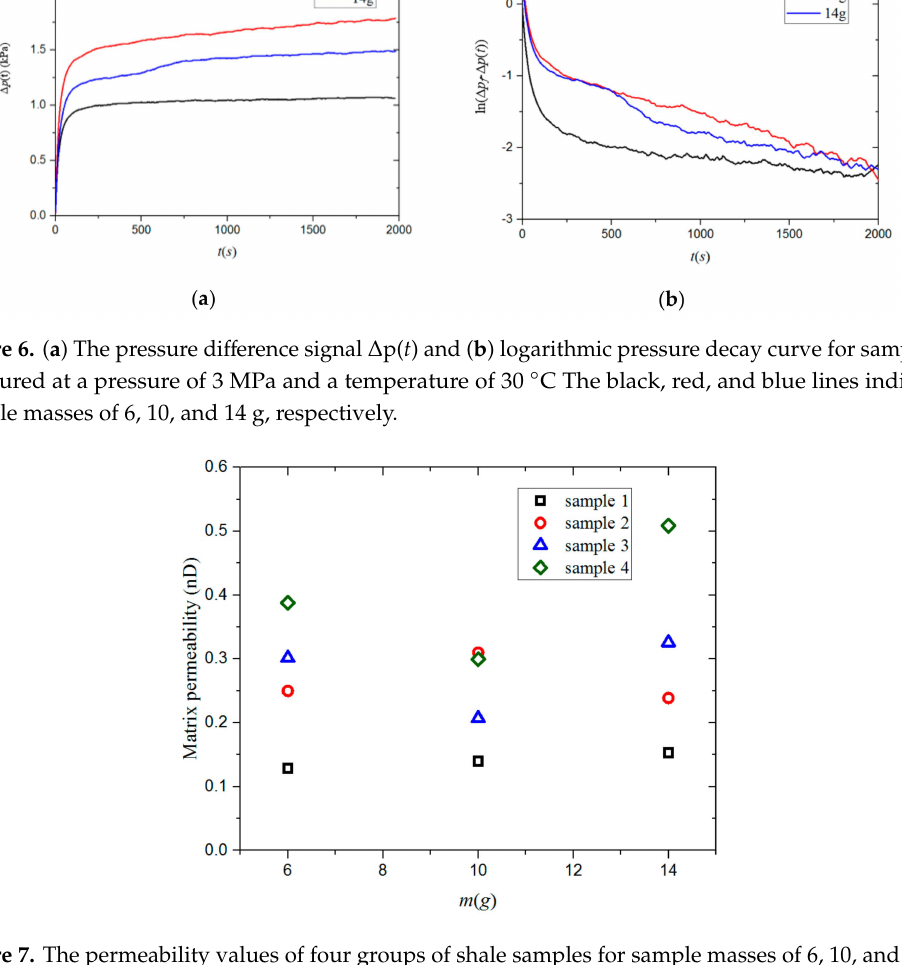
Figure 7. The permeability values of four groups of shale samples for sample masses of 6, 10, and 14 g measured under a pressure of 3 MPa and a temperature of 30 ◦